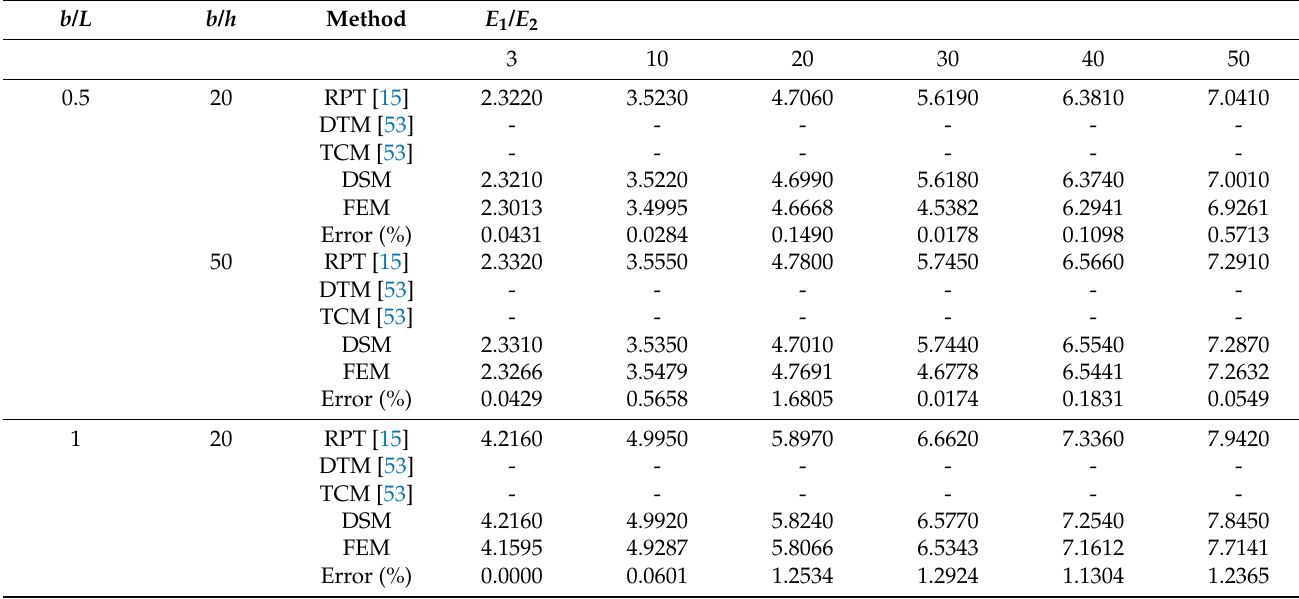
Table 7. Comparison of the fundamental frequency parameters plate with the FC boundary